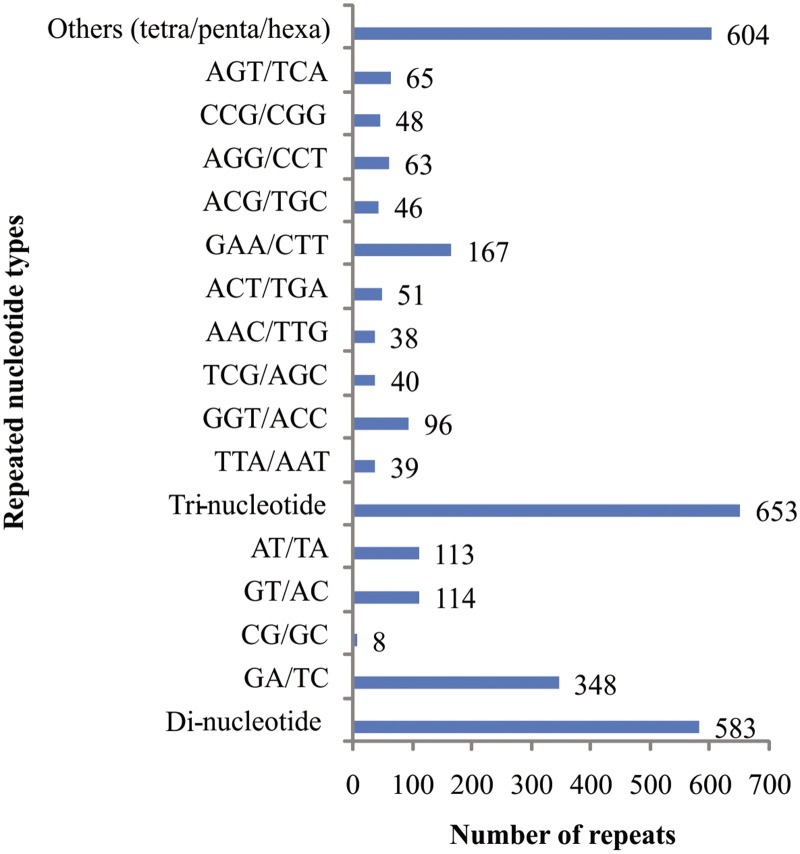
Distribution and frequency of SSR nucleotide classes among different nucleotide types found in the transcriptome sequence.